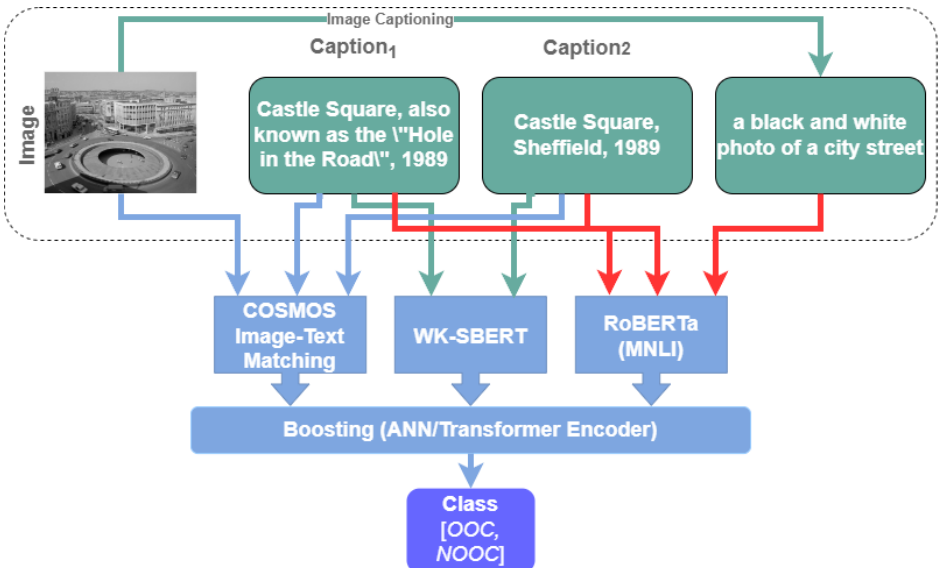
Figure 4. Illustration of boosting with image captioning method. First, the image will be inferred